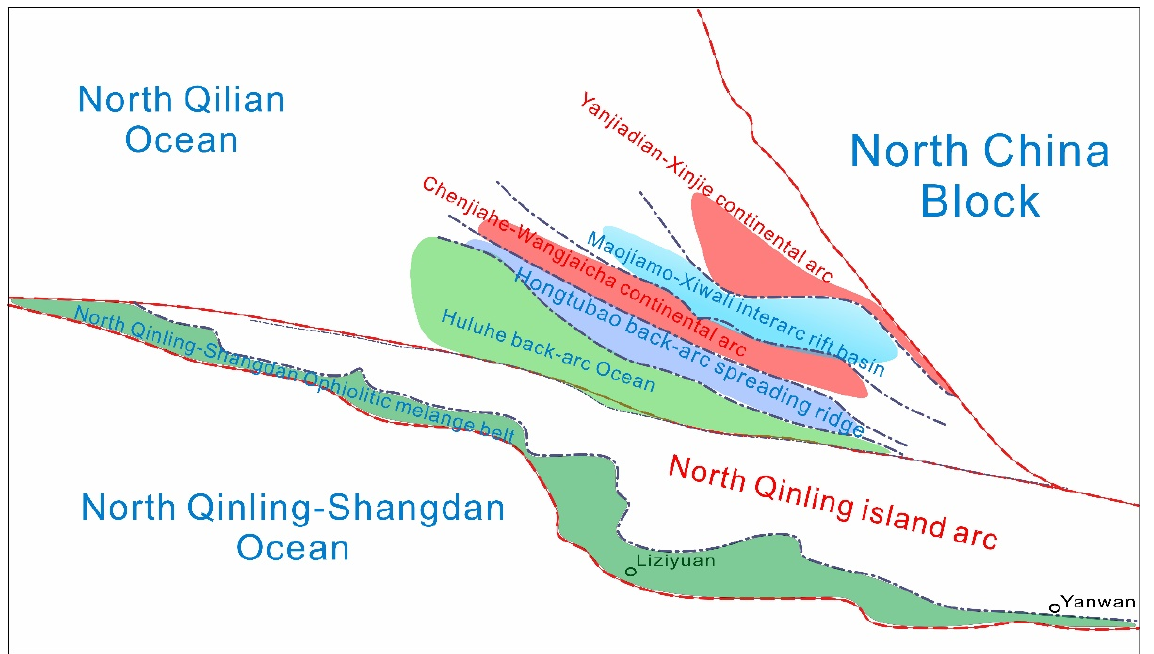
Figure 20. Paleogeographic map of the connection zone in Ordovican-Devonian time. Represented by the 487 ± 9 Ma Dachadaban tholeiites [101] and the 447–430 Ma subduction-related complex from the Laohushan area [102], the North Qilian ocean was still spreading and subducting during ca. 458–454 Ma, and the ocean corresponds to the North Qinling tectonic unit and might link the NCB and Longshan Group, which have been identified as basement of the Qilian Block or NCB from their metamorphic ages, trace element features and detrital zircon spectrum